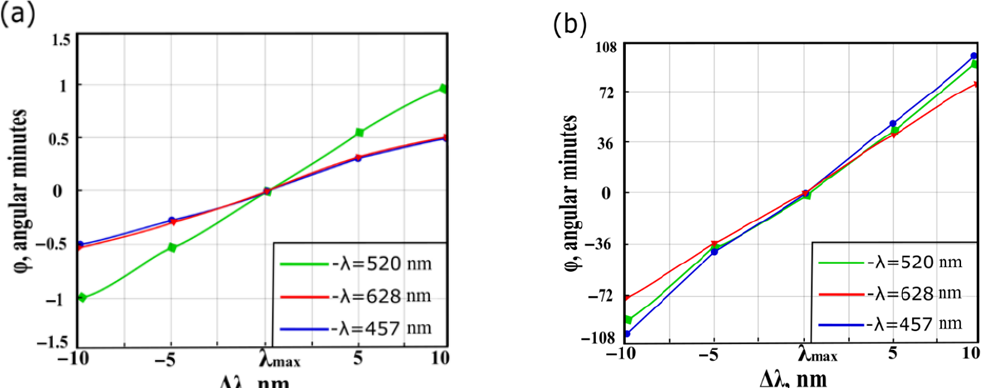
Figure 16. A graph of the dependence of the angular displacement of the output image on the change in the wavelength of radiation. ( a ) A circuit with thermal compensation. ( b ) A circuit without ther- mal compensation.